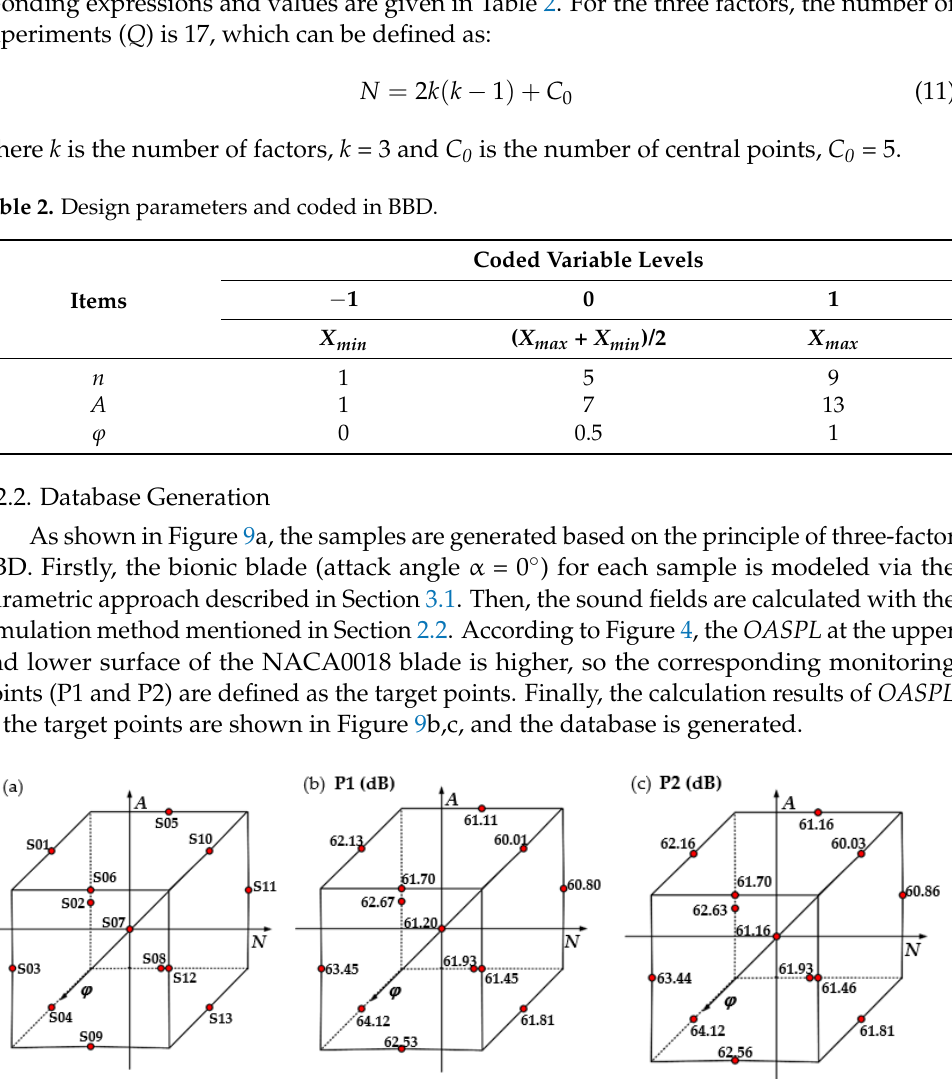
Figure 9. Distribution of the database on BBD. ( a ) BBD sampling; ( b ) OASPL at P1; ( c ) OASPL at P2.